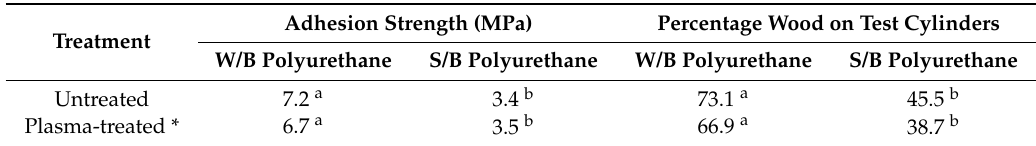
Table 3. Adhesion strength of polyurethane coatings to untreated and plasma-modified black spruce samples, and percentage area of test cylinder faces covered by wood.